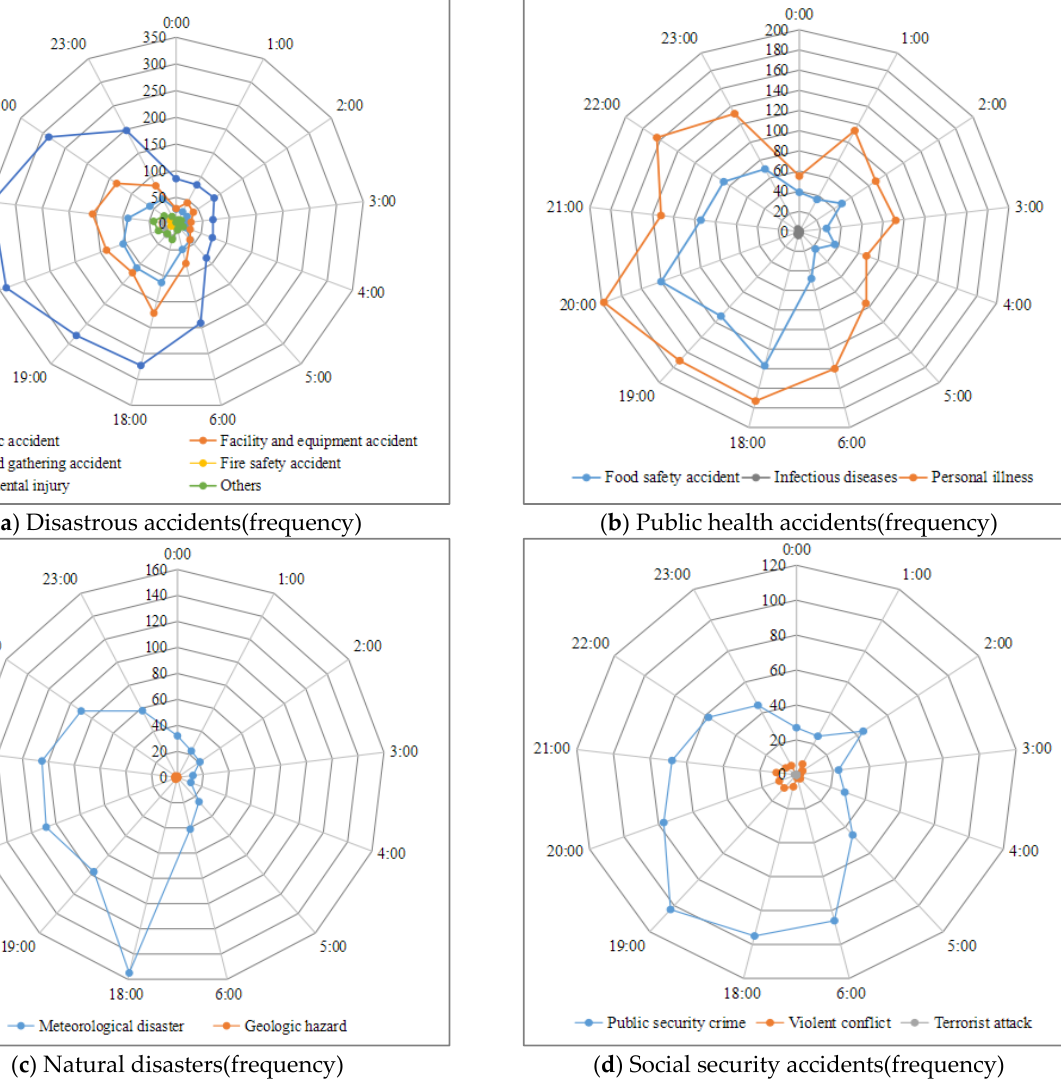
Figure 3. Temporal distribution of urban tourism accident types.